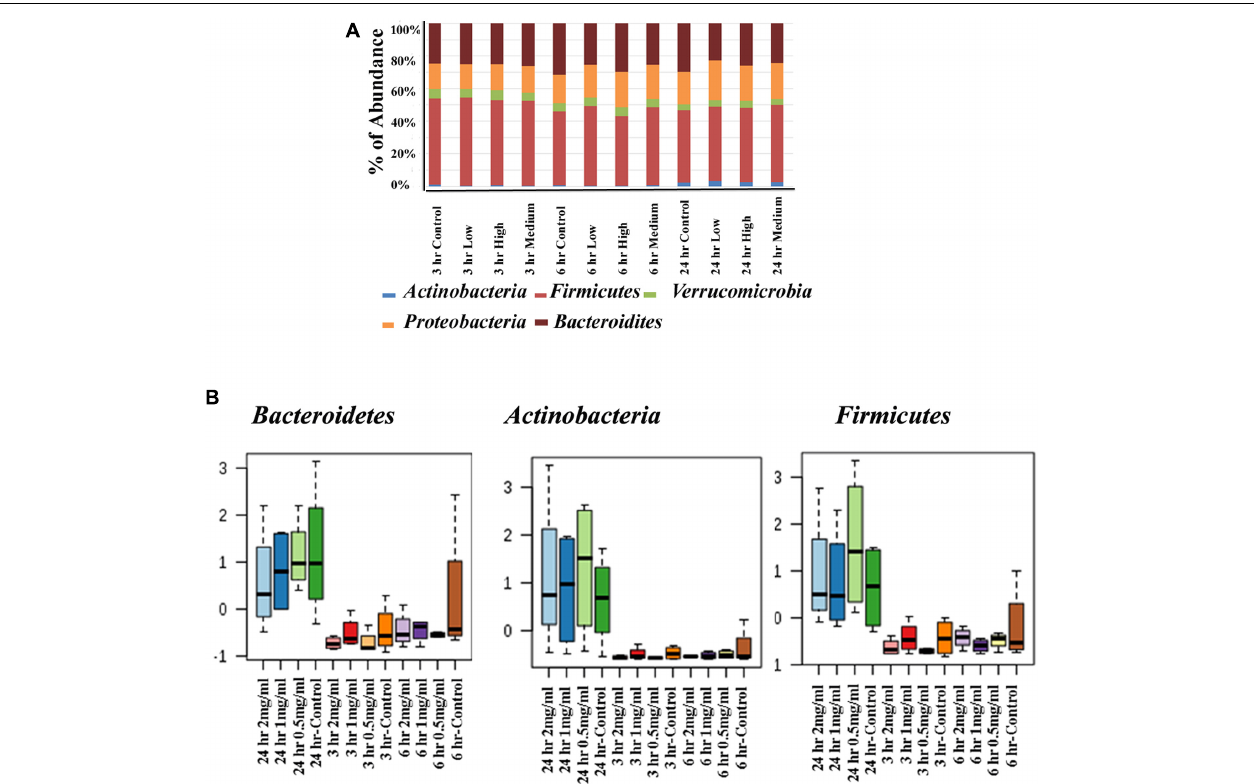
FIGURE 5 | Changes in intestinal bacterial community structure due to aloin treatments. (A) Top panel stack bar diagram shows the abundance of bacteria at phyla level due to aloin treatment. Specifically, Actinobacteria at 24 h in aloin treated samples (shown in blue) over control group. (B) The bottom panel box diagrams show the comparative abundance of three bacterial phyla at 24 h of aloin treated